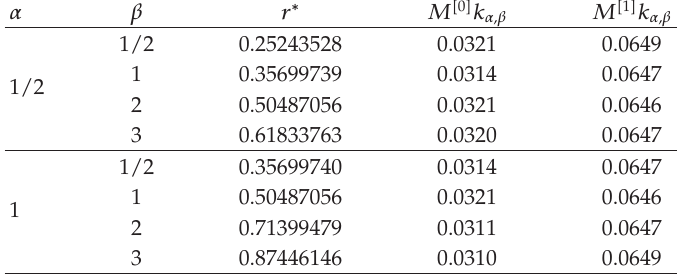
Table 3: Numerical optimal values of the parameter r and maximum relative % errors of the three-term approximate solution k α,β (cid:3) x (cid:4) for each value of α and β . α β r